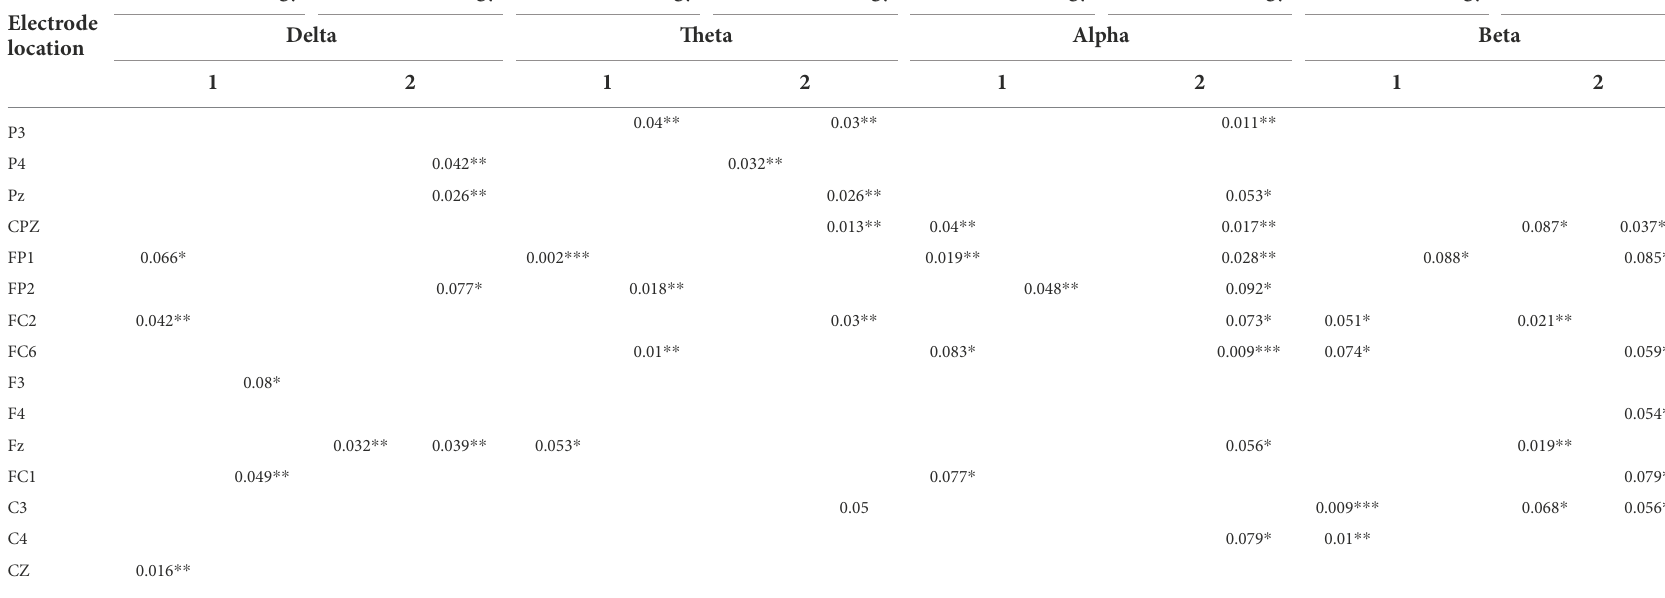
TABLE 4 Significant factors on EEG